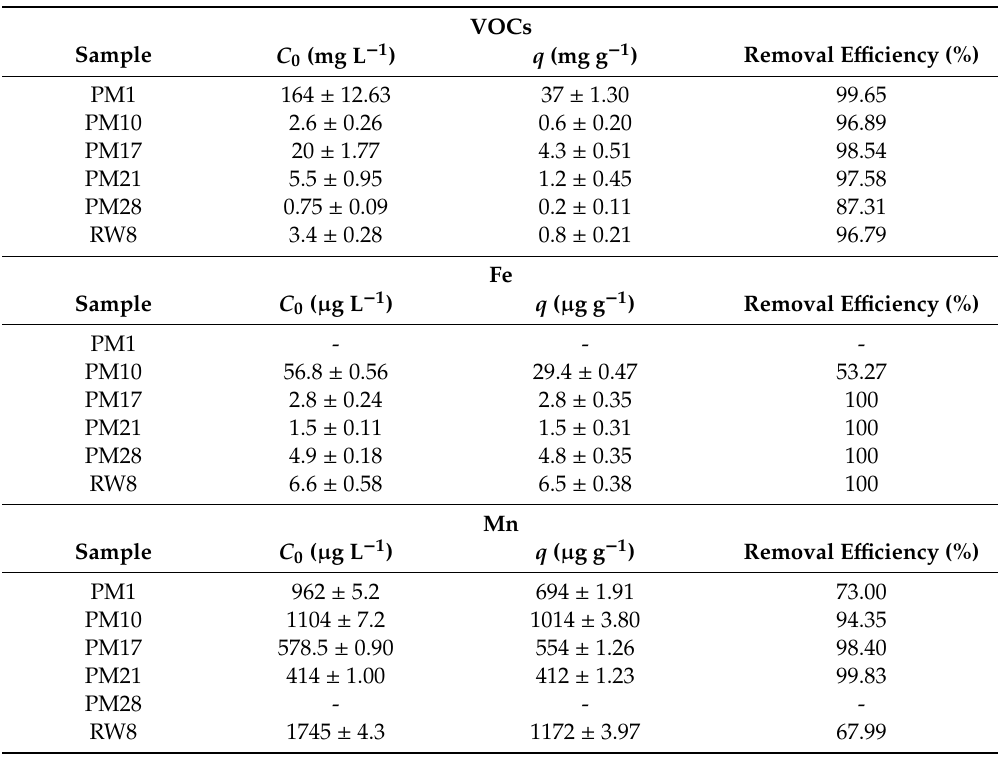
Table 4. Initial contaminants concentration ( C 0 ), contaminants uptake ( q ), and removal e ffi ciency, with standard deviations for VOCs adsorption on zeolite ZSM-5 and for Fe and Mn on zeolite 13X.